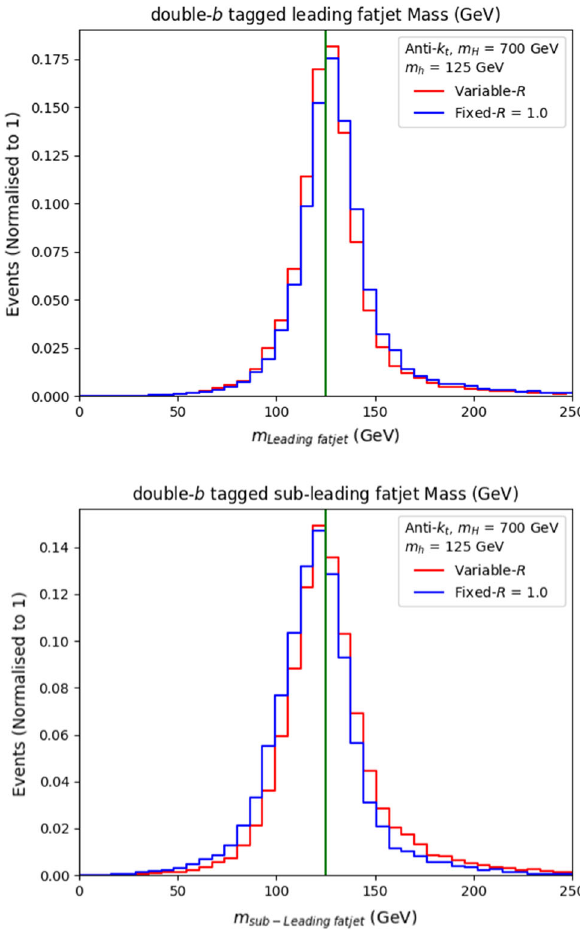
Fig. 7 Upper panel: the double b -tagged leading fat jet invariant mass m h for our BP. Lower panel: the double b -tagged sub-leading fat jet invariant mass m h for our BP